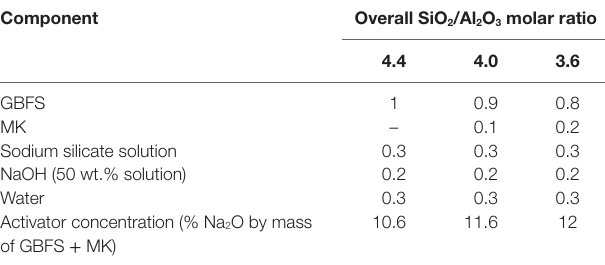
Table 2 | Mix designs of the pastes